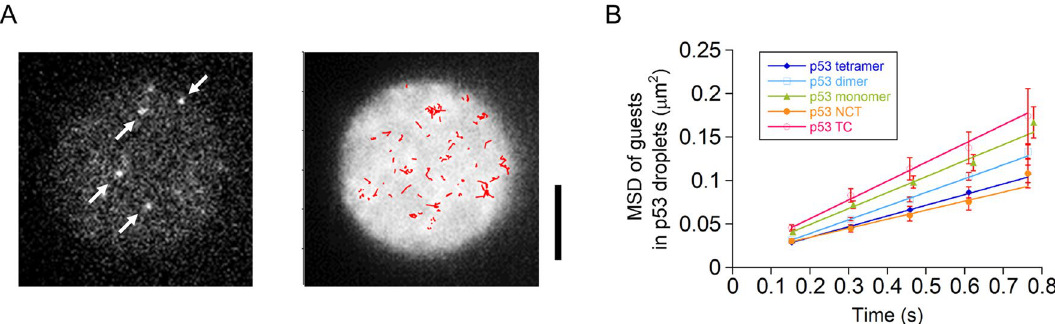
Figure 4. p53 diffuses slowly in the droplets, irrespective of its oligomeric state and droplet-forming disordered domain removal. ( A ) Snapshot (left) and time-averaged (right) fluorescent images of Alexa488-labeled p53 tetramer in a non-labeled p53 tetramer droplet solution. In the left panel, the arrows represent the single p53 molecules. In the right panel, the typical trajectories of single molecules (red) are overlaid. Scale bar denotes 5 μm. ( B ) Mean square displacement (MSD) plots of Alexa488-labeled p53 mutants in non-labeled p53 tetramer droplets. p53 NCT and TC denote mutants lacking the C-terminal domain and N-terminal plus core domains, respectively, maintaining a tetramer. The straight lines show the best-fit linear functions for the MSD data. Error bars denote standard